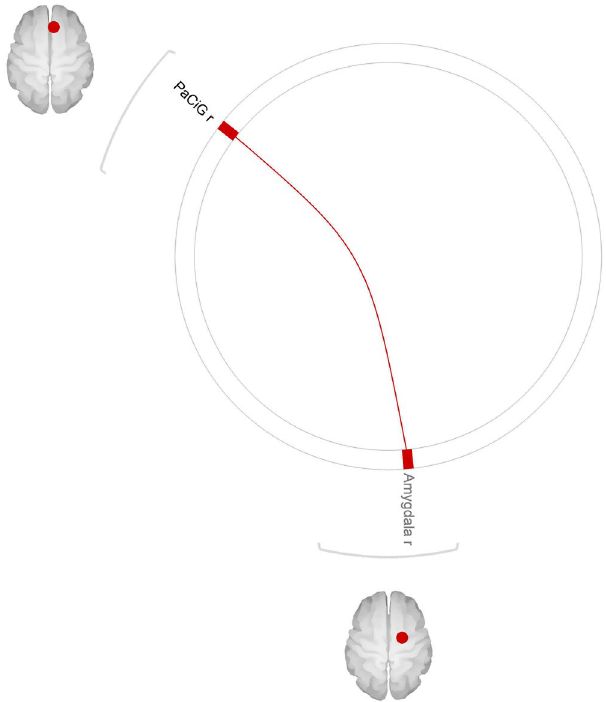
Figure 3. Positive correlation between baseline connectivity and BMI loss at 1 year follow-up. The figures shows seed (black font) to target (grey font) connections where a positive correlations was found between presurgery connectivity and BMI loss over 1 year of follow-up. Results are corrected for multiple comparisons with a FDR approach. The image was generated with the CONN software used for the